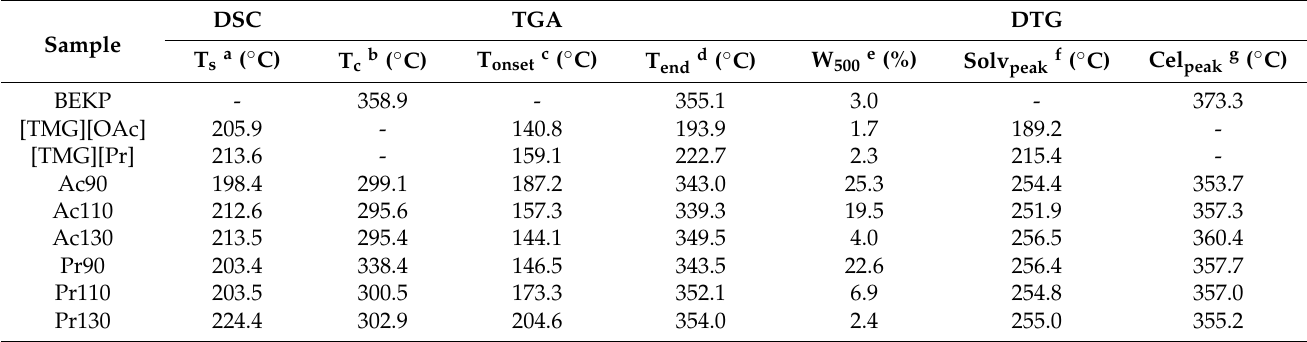
Table 3. Thermal properties of cellulose pulp, solvents and corresponding